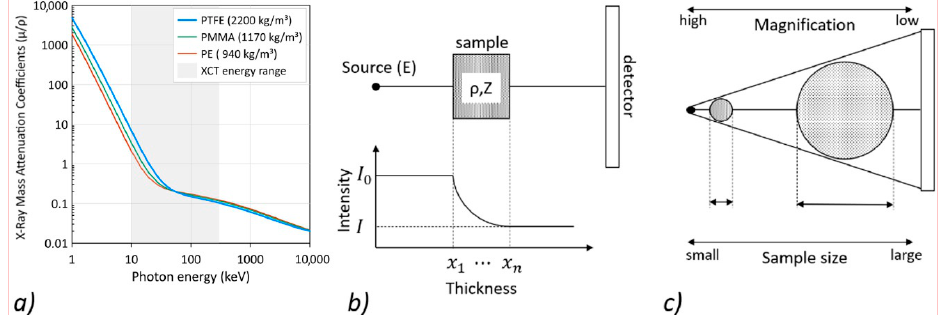
Figure 1. Factors affecting XCT scanning: ( a ) characteristics of X-ray absorption [35], ( b ) principles of XCT operation, ( c ) limitations related to the geometry of the measuring system and the sample size.